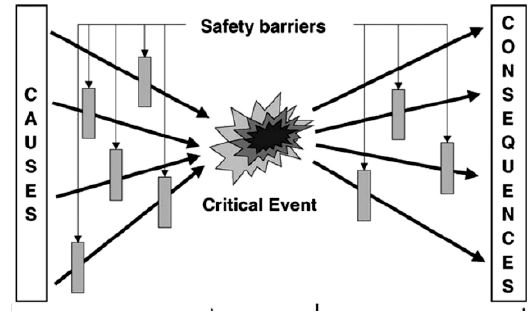
Figure 4. Generic bowtie scheme (source: [15]).